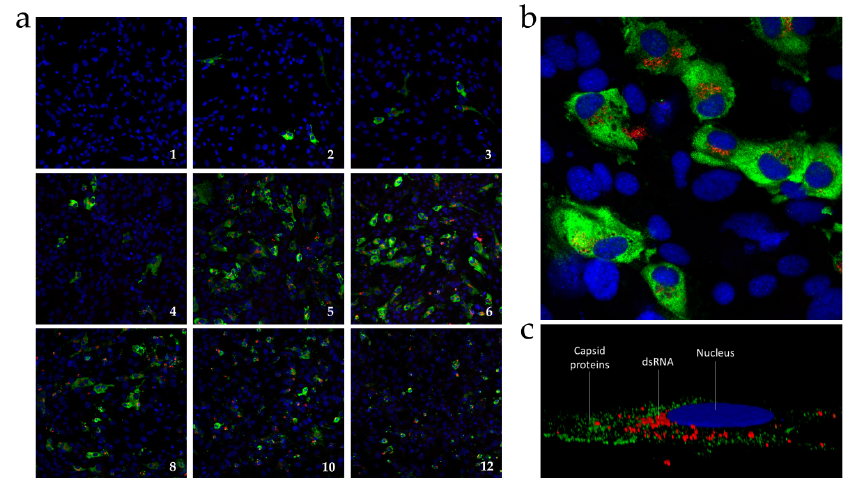
Figure 4. Confocal immunofluorescent analysis of infected RTGill-W1 cells. Cells were stained with anti-capsid protein antibody (green), anti-dsRNA antibody (red), and DAPI (blue); ( a ) Overview of the course of infection from day 1 to day 12 (20 × magnification); ( b ) A 63 × magnification of the infected cells on day 6; ( c ) Three-dimensional reconstruction using ZEN software from Zeiss microscopy.